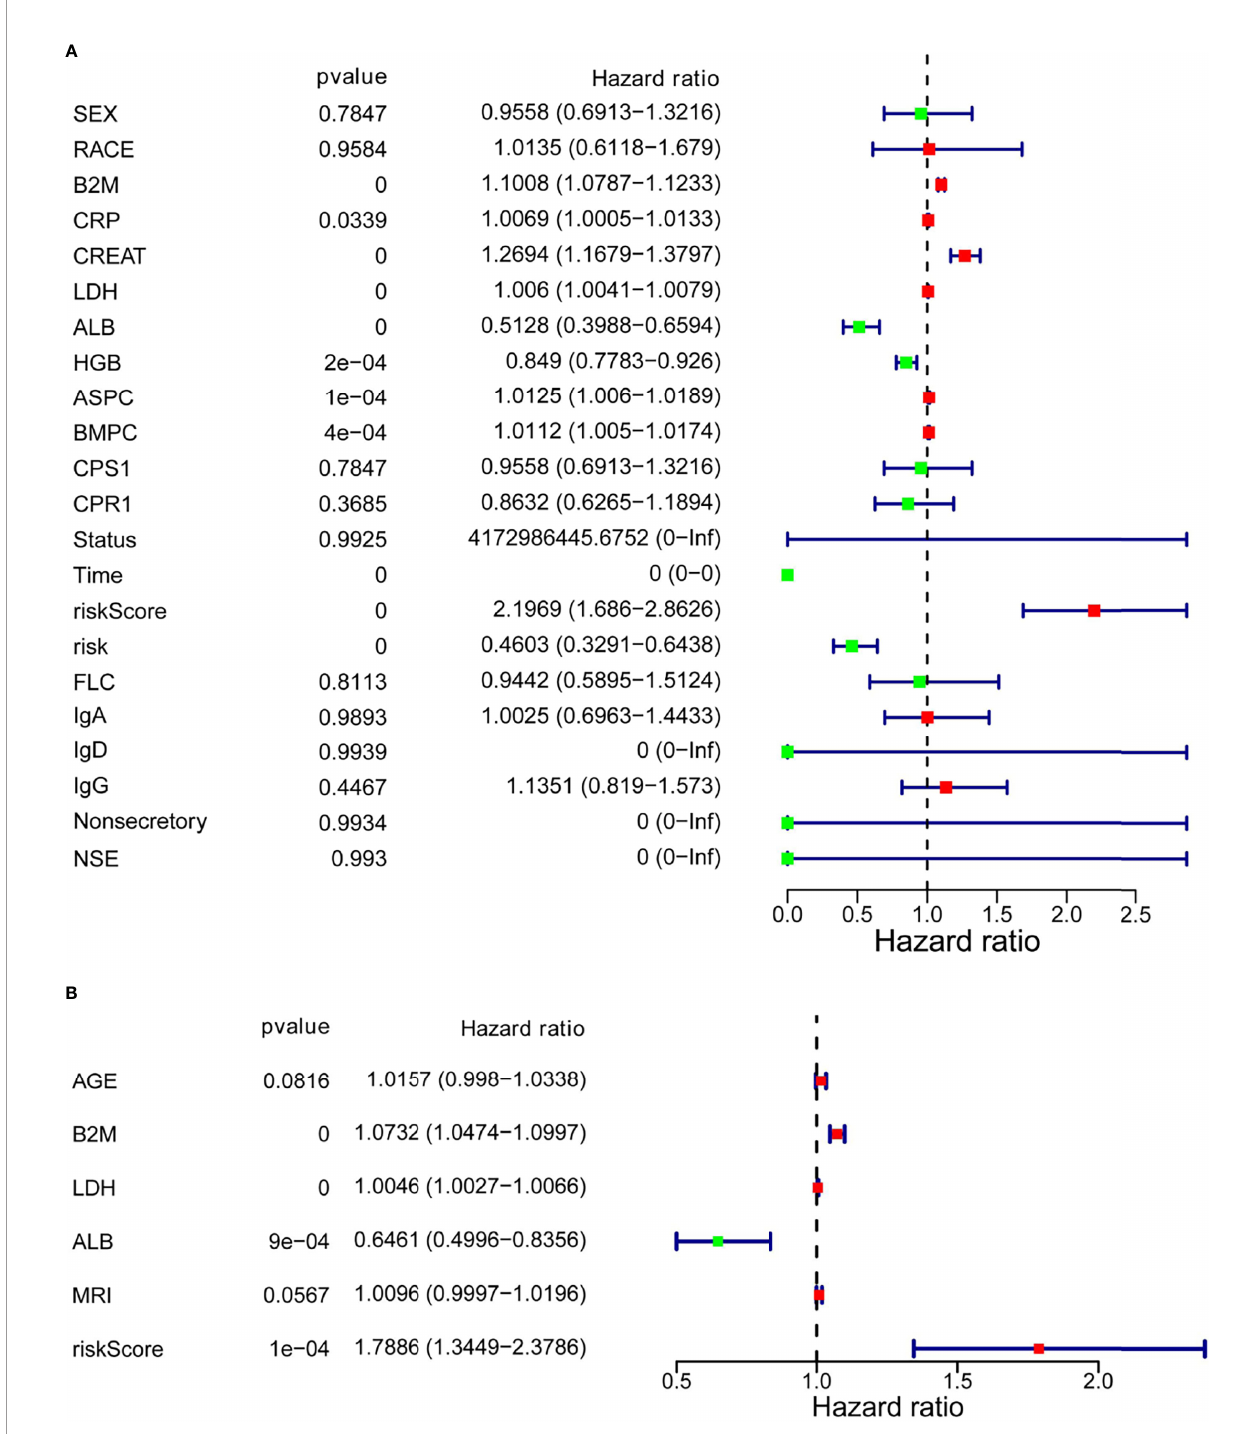
FIGURE 7 | Multivariate Cox regression analysis of the SLC19A1 risk score and clinical risk parameters. (A , B) B2M, LDH, ALB, and SLC19A1 risk scores were markedly correlated with the overall survival of patients with multiple